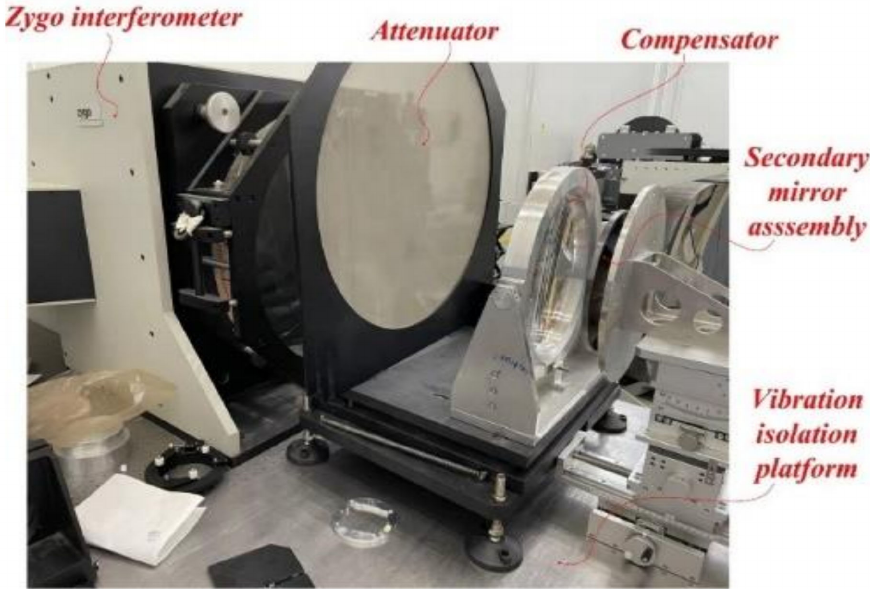
Figure 10. Test of the mirror surface shape error.